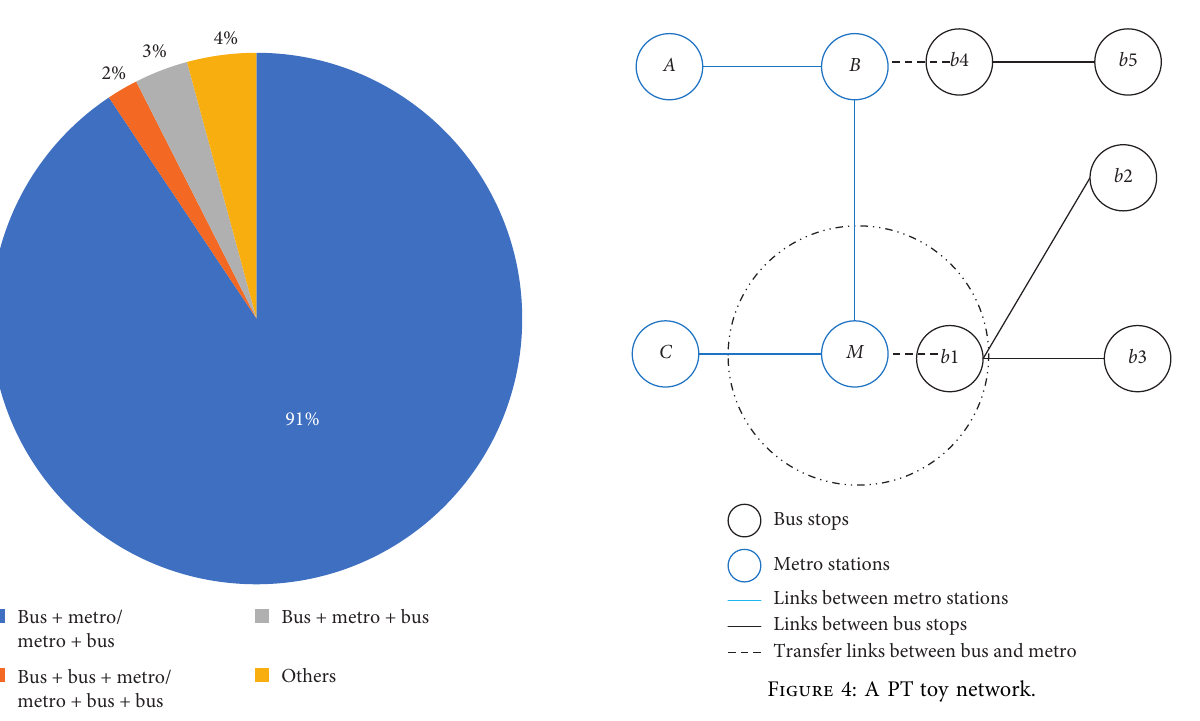
Figure 3: Different transfer patterns between metro and bus (note that the transfers within the metro system or bus system are not considered in this paper and are thus